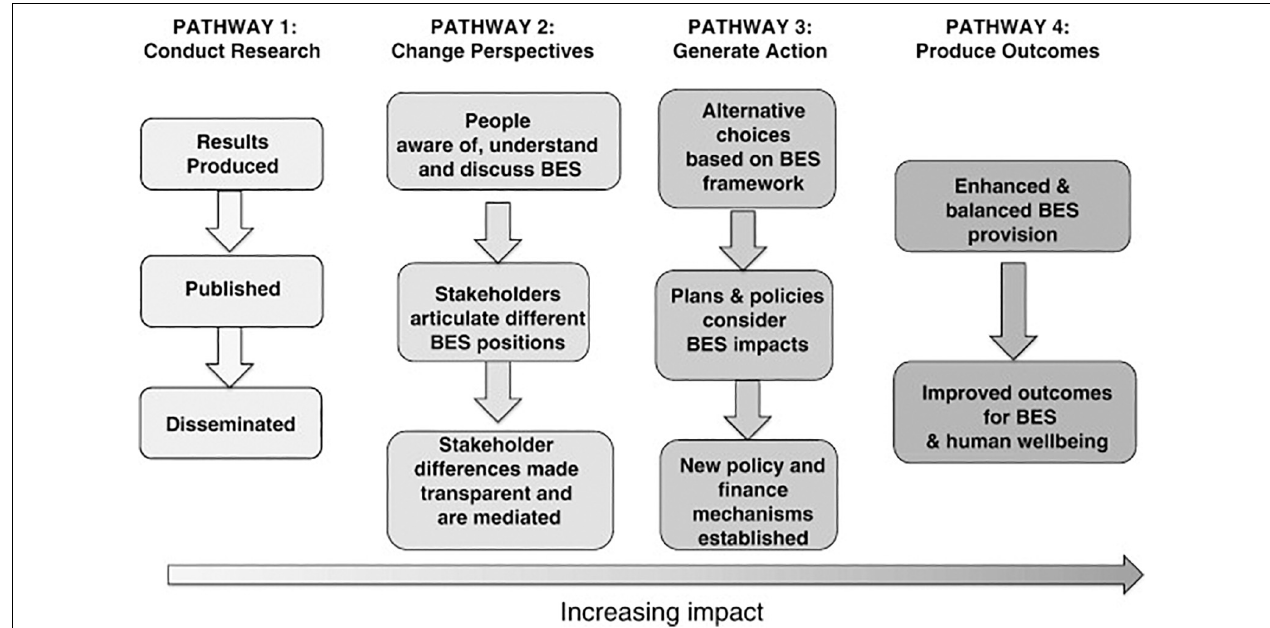
FIGURE 6 | The four pathways of impact for biodiversity and ecosystem services (BES) information on decision-making process. A pathway means a level of success achieved when science and policy act together to achieve more sustainable management of CMES. Pathway 1 represents the creation of new, high-quality and relevant information on CMES. Pathway 2 provides new understanding, thus, raising awareness or achieving mind-shift. Pathway 3 represents the influence of CMES information on specific actions and the behavior of decision-makers. Pathway 4 achieves specific outcomes in terms of developing new policy or finance mechanisms, and making measurable improvements in ES provision, biodiversity and human wellbeing. Reproduced from Ruckelshaus et al. (2015); open access under the Creative Commons Attribution-Non-commercial-No Derivatives License - CC BY NC ND).